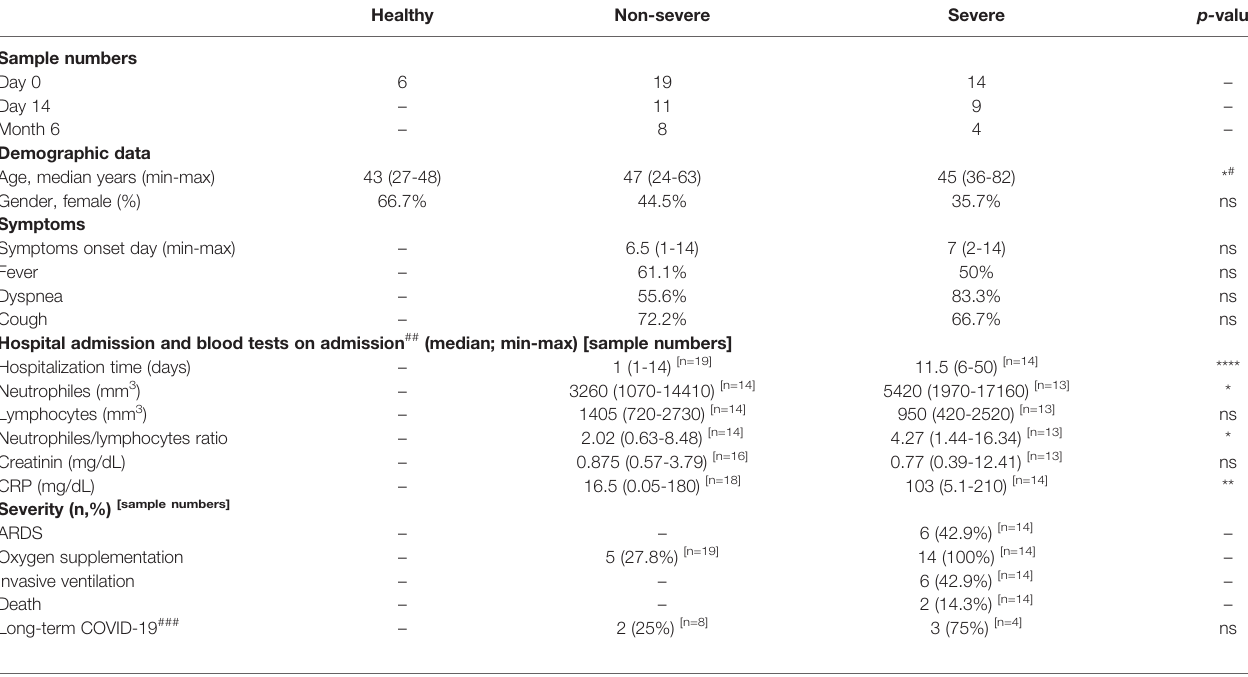
TABLE 1 | Demographic and clinical characteristics of COVID-19 patients and healthy controls included in the